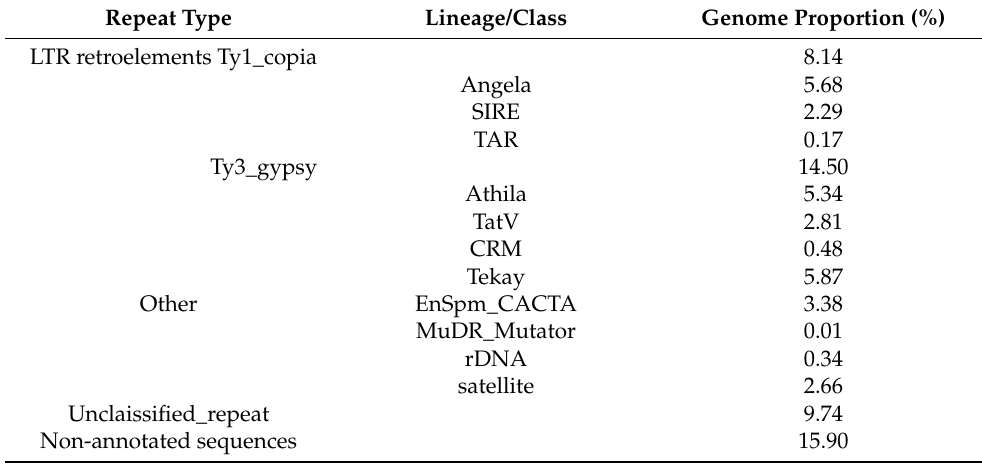
Table 3. Repeat composition of P. libanotica identified from clustering analysis of Illumina